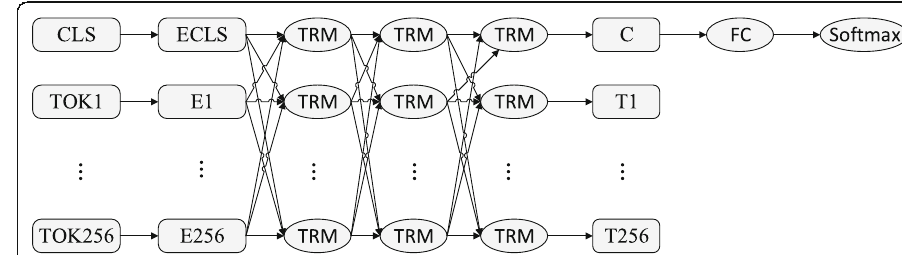
Fig. 5 Text classification BERT fine-tuning model structure